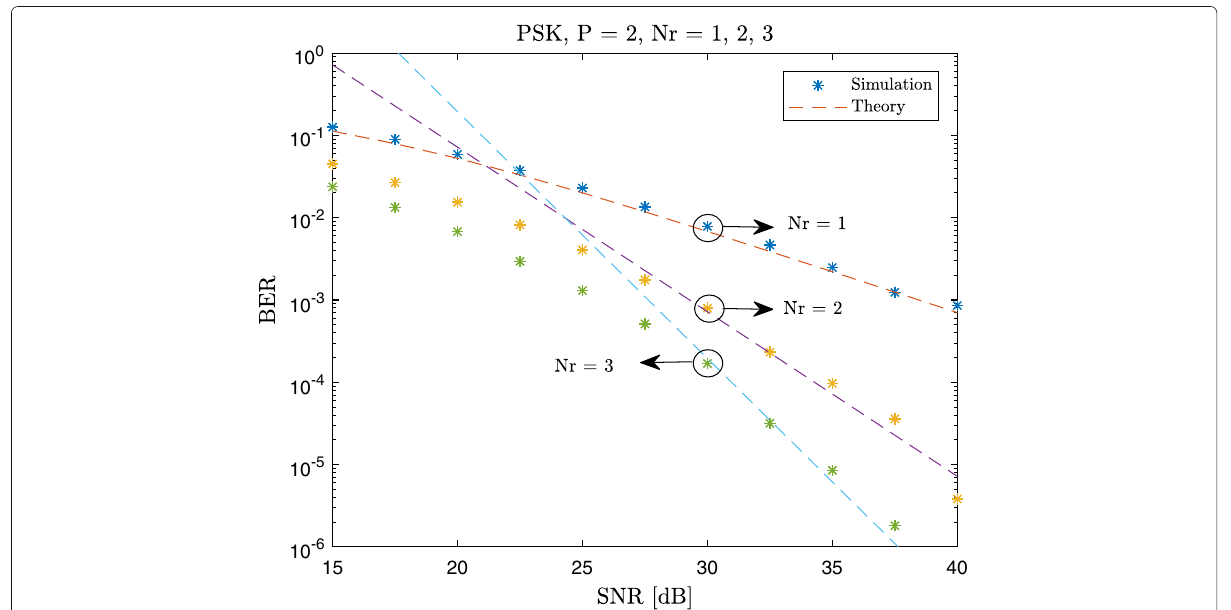
Fig. 9 ABEP of RecAnt-SM ( P = 2, N r = 1,2,3, M = 2 (BPSK)). The results are obtained by using RP 1 and RP 2